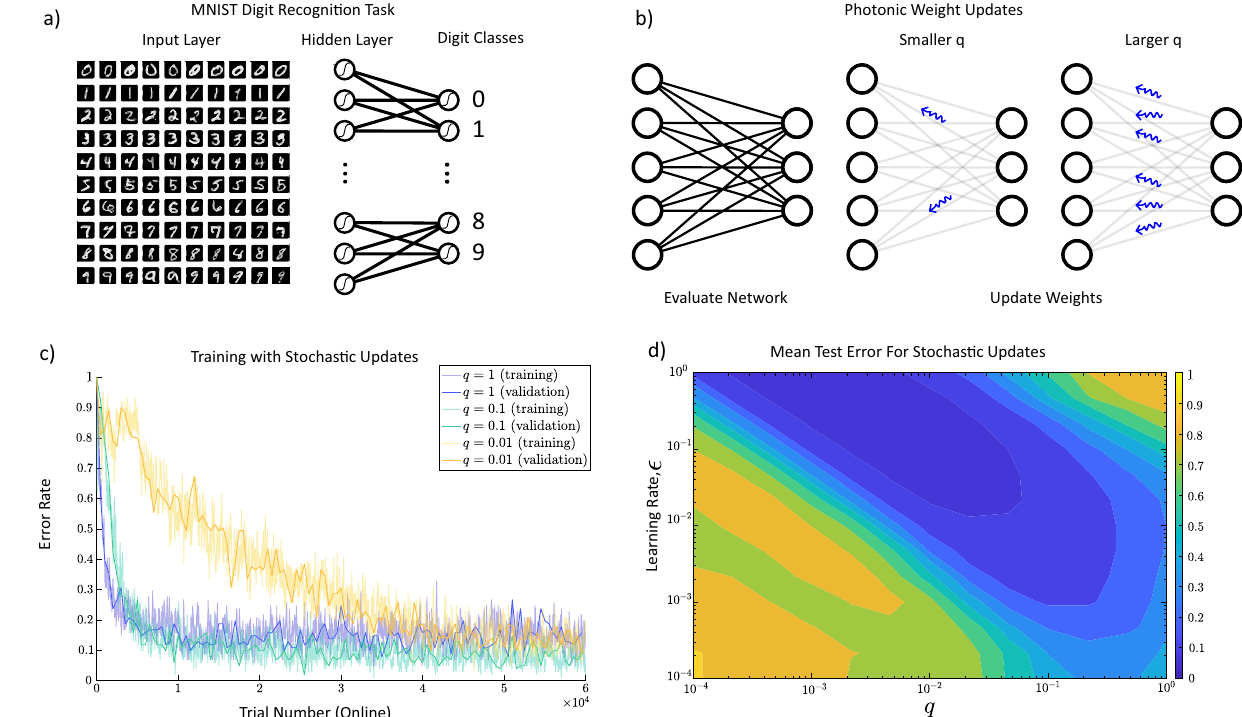
Figure 2. Training of a 3-layered artificial neural network with 500 neurons in the hidden layer by the stochastic photonic updates. ( a ) The network is trained for an MNIST hand-written recognition task. For each training trial, the network receives sets of handwritten digits as input and their corresponding digit classes as the target output. ( b ) The network computes the feedforward weights and updates them with stochastic photonic feedback. The parameter q is the probability of transmitting one photon per neuron, and as it gets larger (closer to 1), the network sends more backward photons and behaves closer to the conventional backpropagation algorithm. ( c ) As the trial number grows, the error rate (that is the moving average of the past 100 trial errors, see Eq. (11) converges to a small value and the training completes. This convergence happens even for small values of q but after greater numbers of trials. Here, the learning rate, ǫ = 0.01 , has been kept small for the stability of the network. ( d ) The test error, which measures the distance between the target and the output of the trained model, is averaged over 10 repetitions of the test experiment for each different values of q and ǫ (see “Methods” for